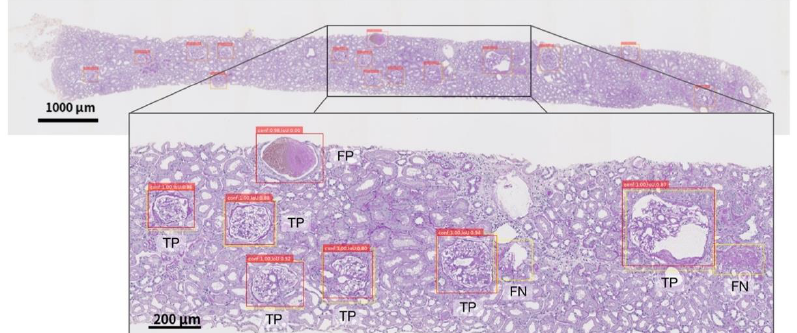
Figure A2. Example of glomerular detection results from a WSI. The yellow frames indicate the ground truth of the glomerular. The red frames indicate the predicted glomerular regions proposed by Faster R-CNN. The regions with overlapped yellow and red frames indicate a true positive (TP), the regions surrounded by only red frames indicate a false positive (FP), and the regions surrounded by only yellow frames indicate a false negative (FN). Table A2. Results of the univariate regression analysis.